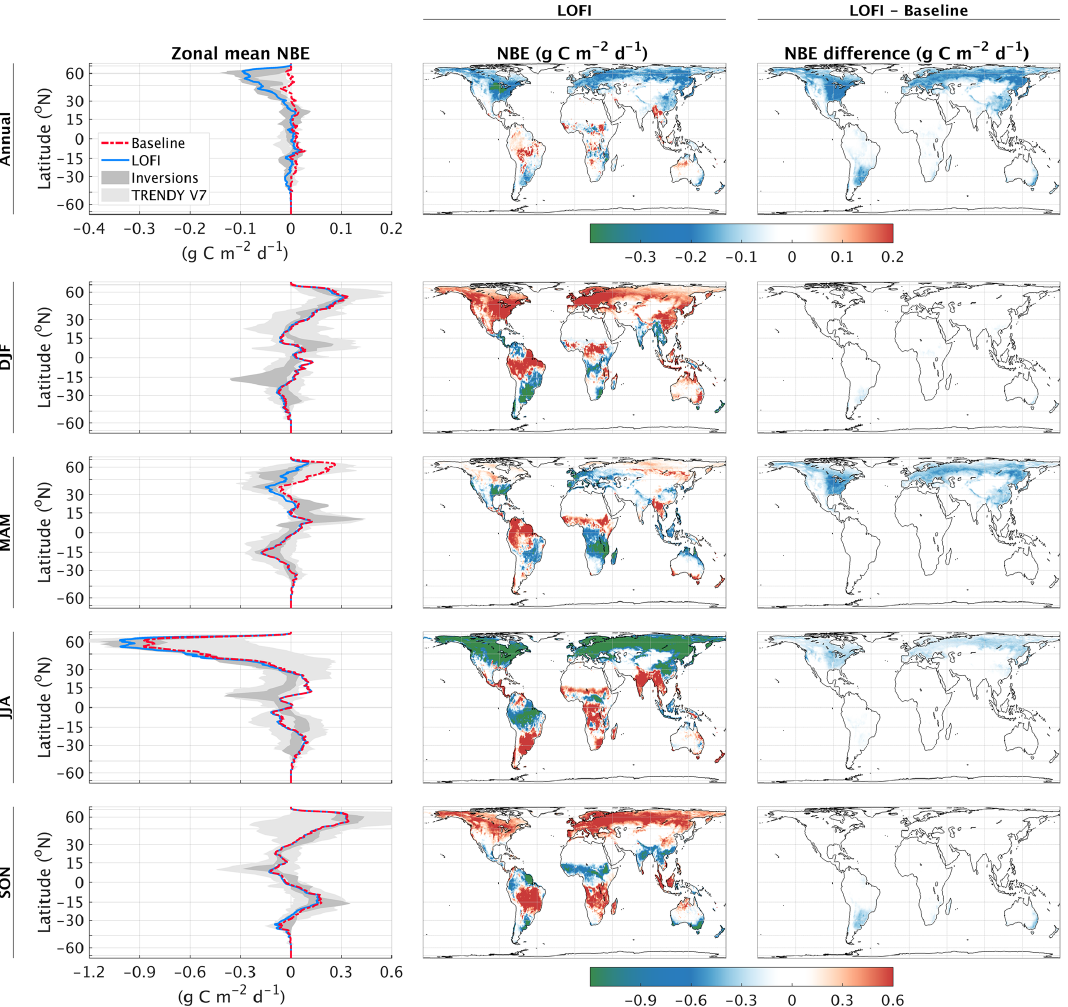
Figure 3. Climatologies (2003–2015) of NBE from the fluxes excluding (baseline) and including (LoFI) the empirical sink. The first row depicts annual averages, and each subsequent row depicts averages over different seasons. In the left column, zonal-mean NBE from the baseline fluxes (dash–dot red) and LoFI fluxes (solid blue) are plotted along with the ranges of the inversion ensemble (dark grey) and the TRENDY V7 ensemble (light grey), while the middle and right columns show maps of the LoFI fluxes (middle) and the magnitude of the empirical sink (right), i.e., the difference between the LoFI and baseline fluxes. Note that the scale of the annual average plots is 3 times smaller than that of the seasonal average